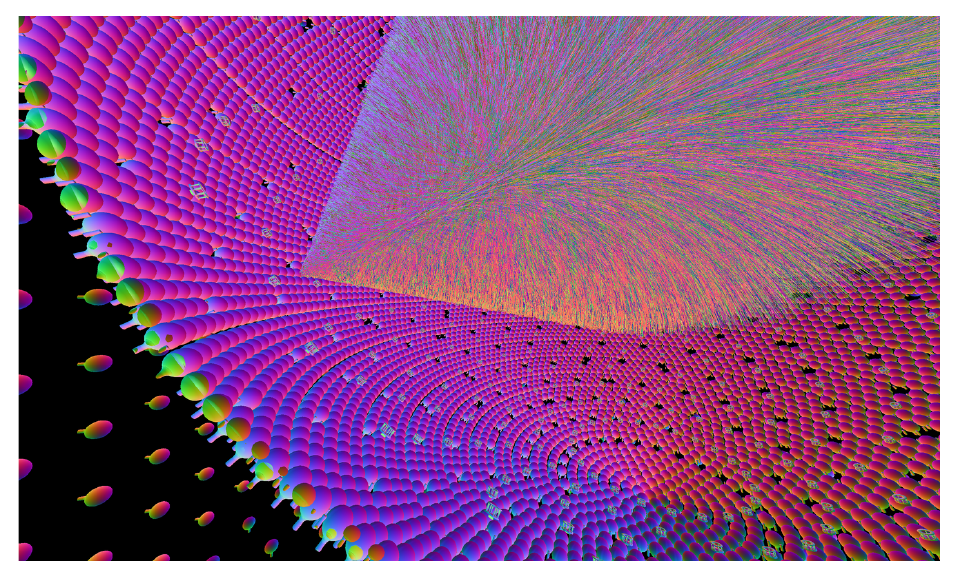
Figure 1. Cutaway OpenGL rendering of millions of simulated optical photons from a 200 GeV muon crossing the JUNO liquid scintillator. Each line corresponds to a single photon with line colors repre- senting the polarization direction. Primary particles are simulated by Geant4, scintillation and Cerenkov "gensteps" are uploaded to the GPU and photons are generated, propagated and visualized all on the GPU. Representations of some of the many thousands of photomultiplier tubes that instrument the liquid scintillator are visible. The acrylic vessel that contains the liquid scintillator is not